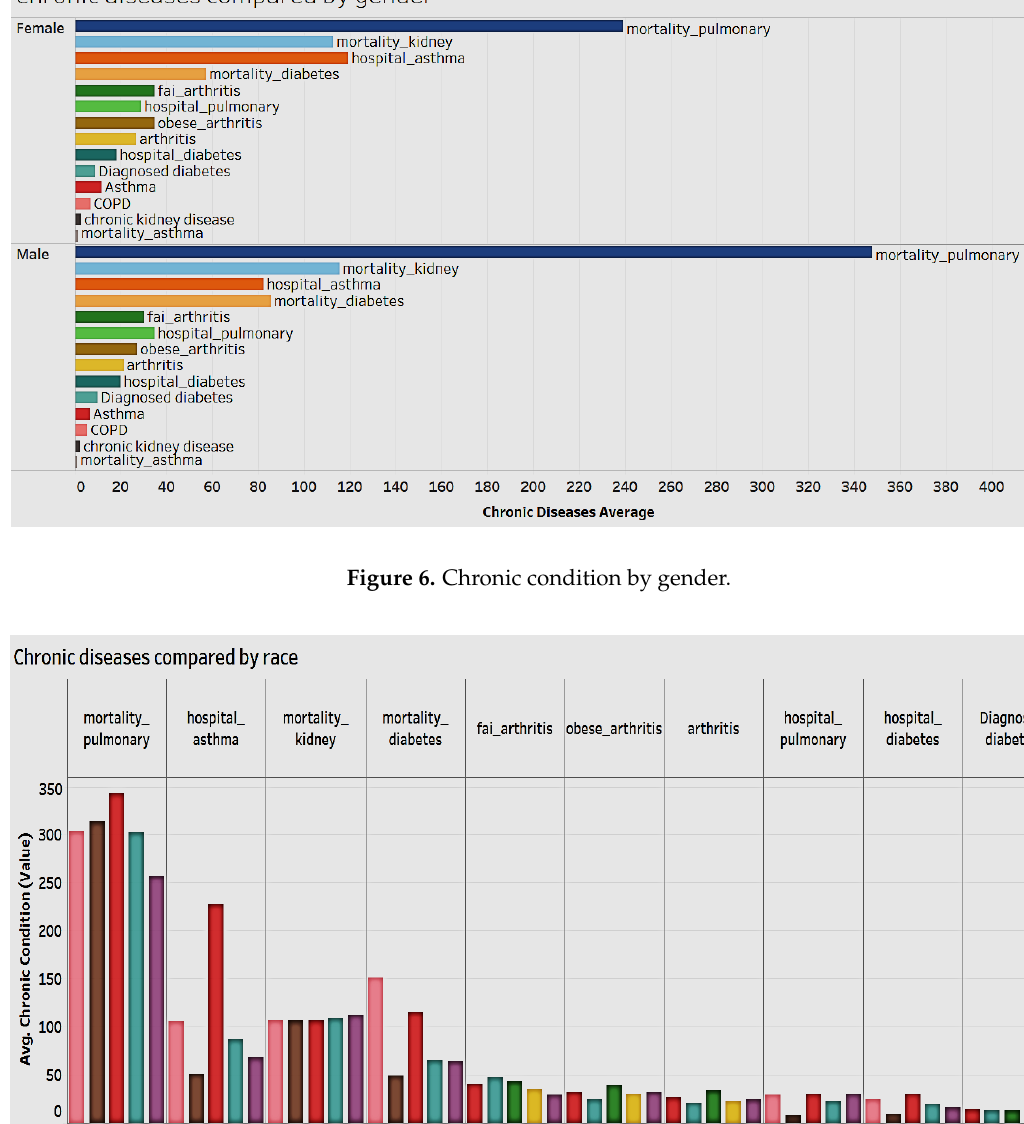
Figure 7. Chronic conditions by race.